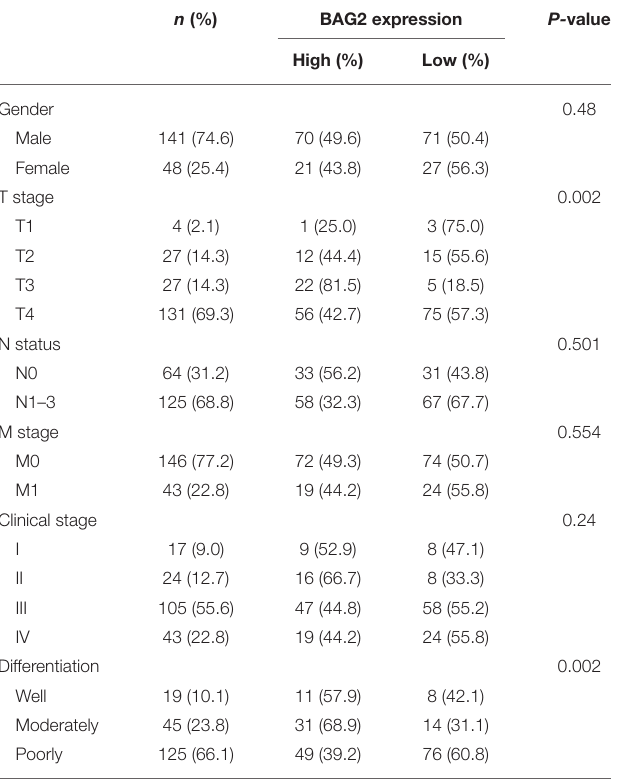
TABLE 1 | Clinicalpathological implications of BAG2 expression in gastric patients. TABLE 2 | Relationship between BAG2 expression and clinicalpathological